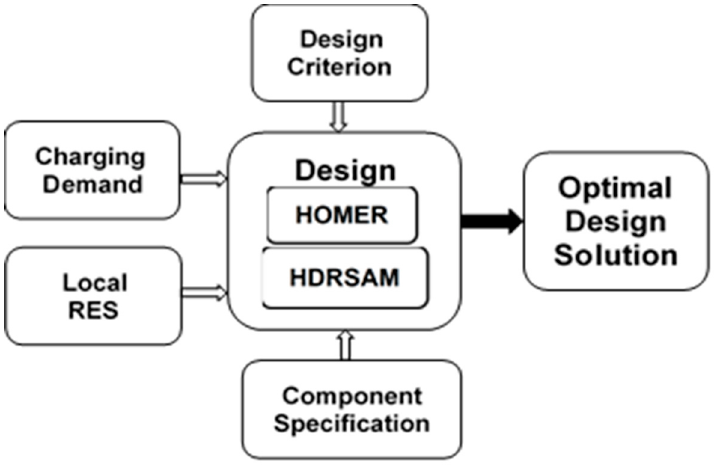
Figure 2. The flowchart of the system design.